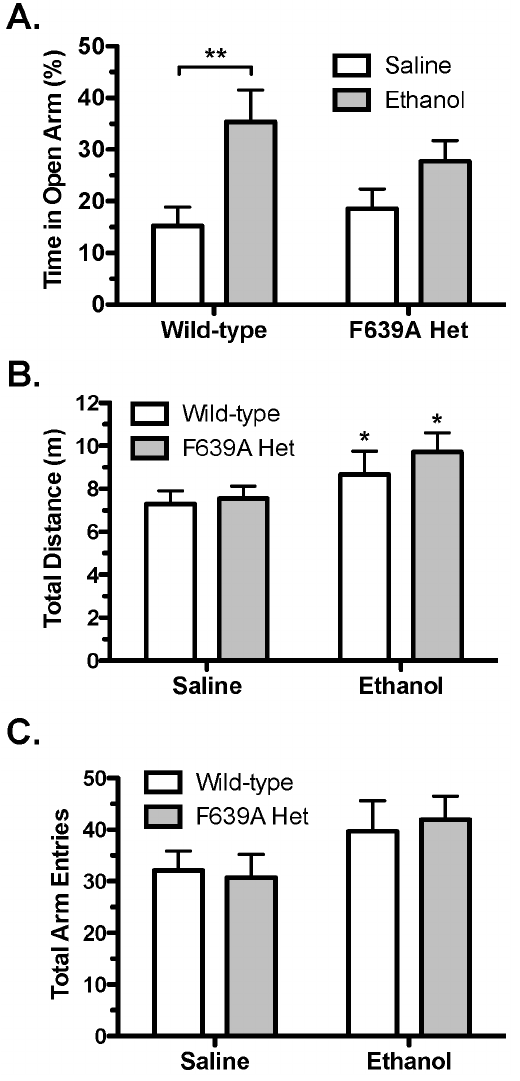
Figure 6. Anxiolytic response to ethanol is blunted in F639A Het mice. ( A ), Percent of time (mean 6 SEM) spent in the open arms of an elevated zero maze following injection of saline or 1.25 g/kg ethanol in F639A Het and wildtype mice (n=10 for each group). Symbol ( * ): value significantly different from saline ( ** p , 0.01, two-way ANOVA, Bonferroni’s post hoc test). ( B ), Total distance traveled and ( C ), total number of arm entries on the elevated zero maze. Symbol ( * ): value significantly different from saline ( * p , 0.05, two-way ANOVA, Bonferroni’s post hoc test). Values are mean 6 SEM.